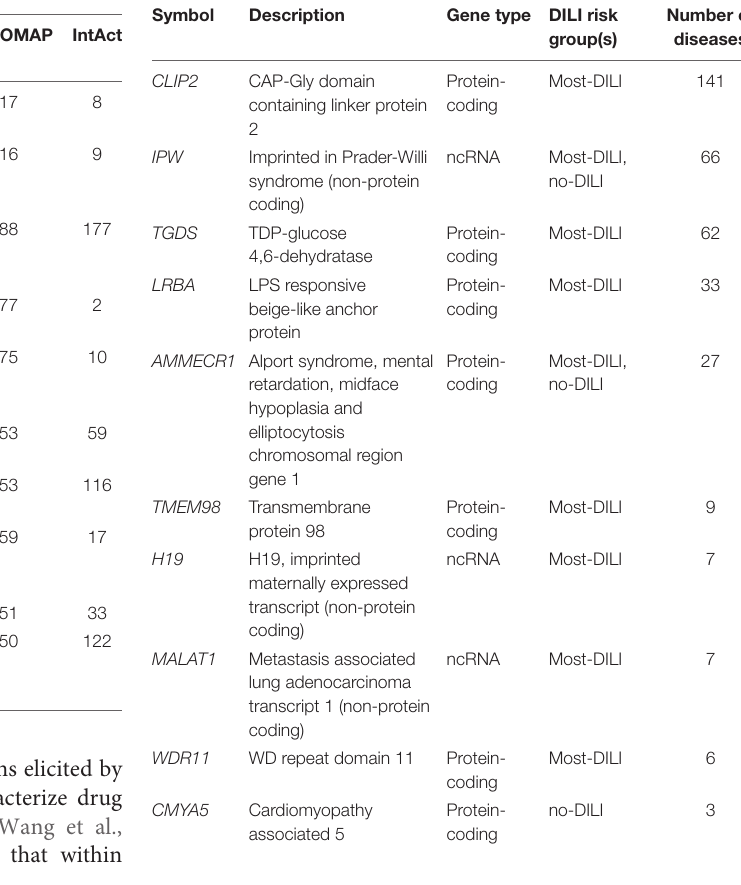
TABLE 4 | Top 10 genes associated to diseases in DisGeNET (curated data).